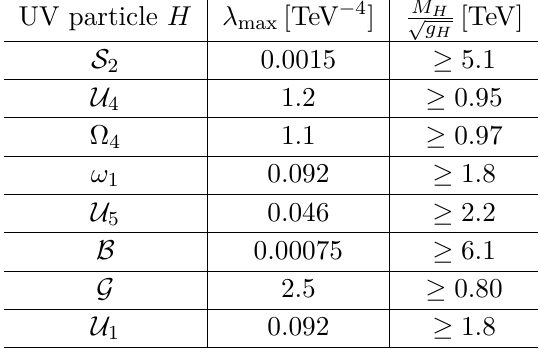
Table 7 . Lower bounds for the UV scale M H / our purposes roughly speaking equivalent to being agnostic about C 4 and C 5